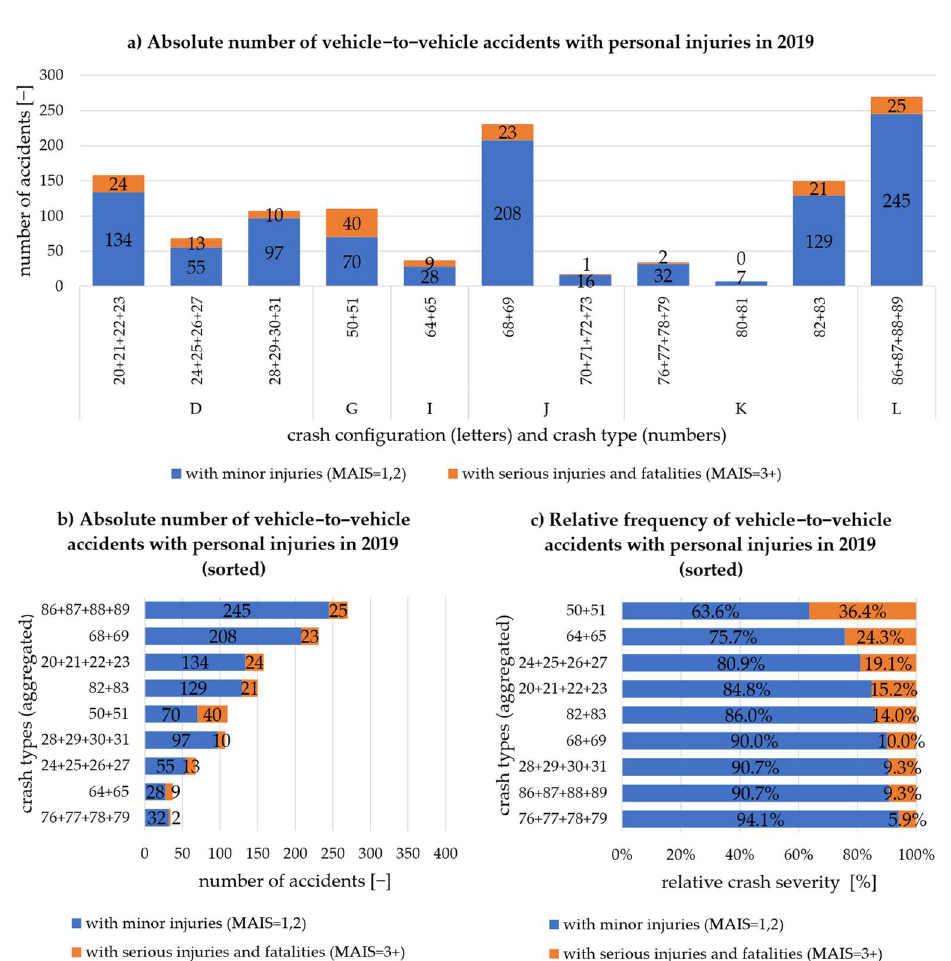
Figure 4. Vehicle-to-vehicle crashes with personal injury in 2019 according to CISS [19] broken down into crash types: ( a ) absolute number of all crash configurations; ( b ) absolute number of all relevant crash configurations sorted; ( c ) relative frequency of severe crashes sorted by the largest relative proportion of serious injuries and fatalities.